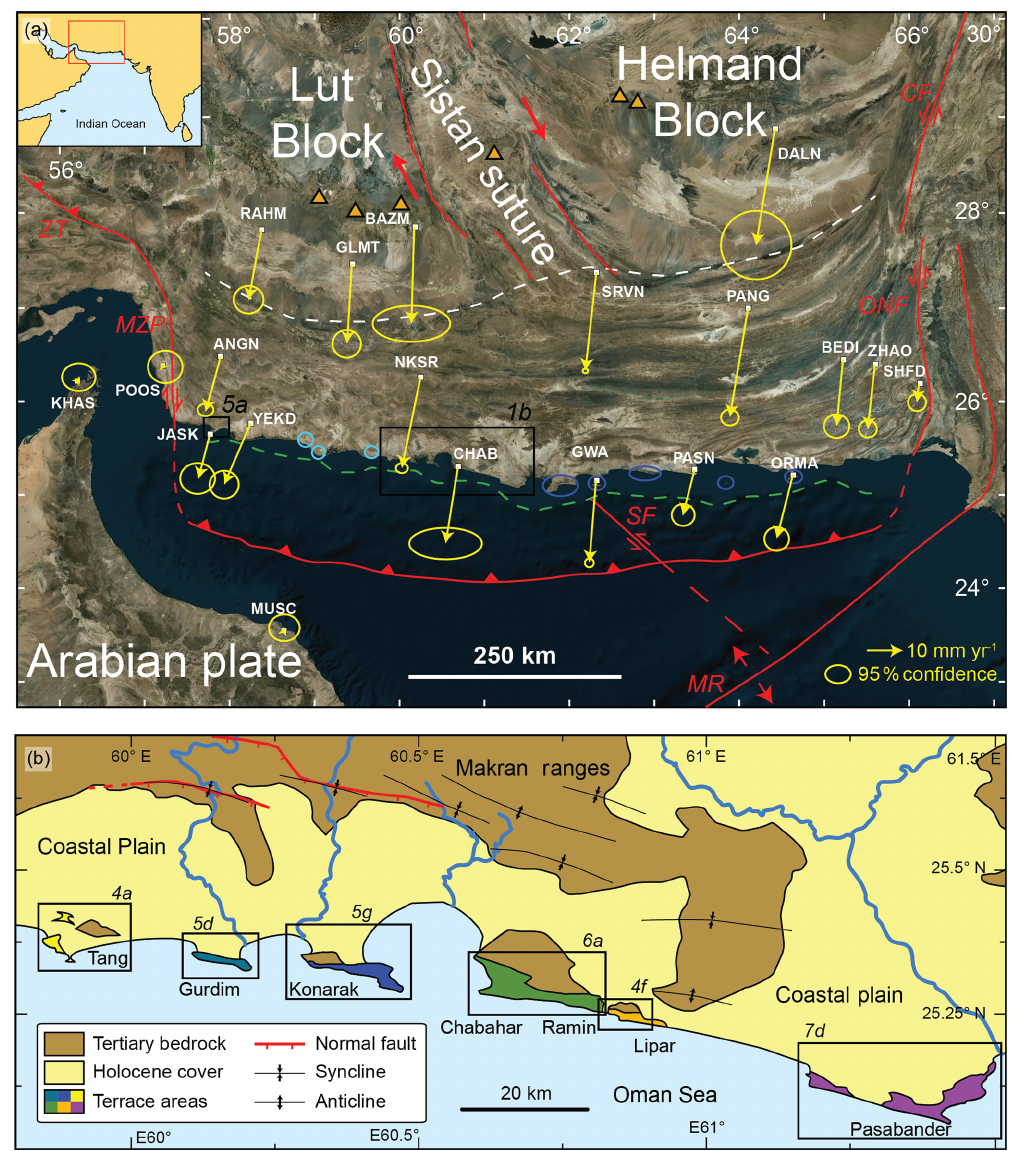
Figure 1. Map of the studied areas. Black squares: terraces studied, visited and mapped in this paper (Figs. 4–7, italic numbers). (a) Tectonic framework on a satellite image (Bing). Yellow arrows and circles represent GPS velocities and 95% confidence ellipses, with a fixed Arabian plate reference, compiled by Penney et al. (2017) from the literature (Bayer et al., 2006; Frohling and Szeliga, 2016; Khan et al., 2008; Masson et al., 2007; Penney et al., 2017; Peyret et al., 2009; Vernant et al., 2004; Walpersdorf et al., 2014). Red lines and arrows: simplified major fault structures and relative motions. White dashed line: rough northern limit of the sedimentary accretionary prism. Green dashed line: shelf break. Blue circles: other occurrences of marine terraces along the Iranian (light blue) and Pakistani (dark blue) Makran. ZT: Zagros thrust; MZP: Minab–Zendan–Palami fault zone; SF: Sonne fault; MR: Murray Ridge; ONF: Ornach–Nal fault; CF: Chaman fault. Orange triangles: active volcanoes. (b) Simplified map of the studied region. Faults and folds from the geological maps of Iran; 1 : 100000 (Kahir and Peersohrab sheets, Samadian et al., 1994,